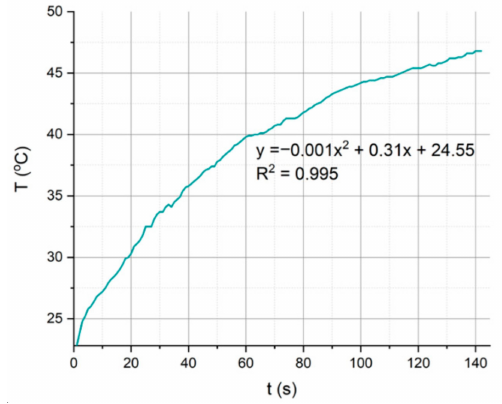
Figure 7. The temperature changes of the LTCC microfluidic − microwave